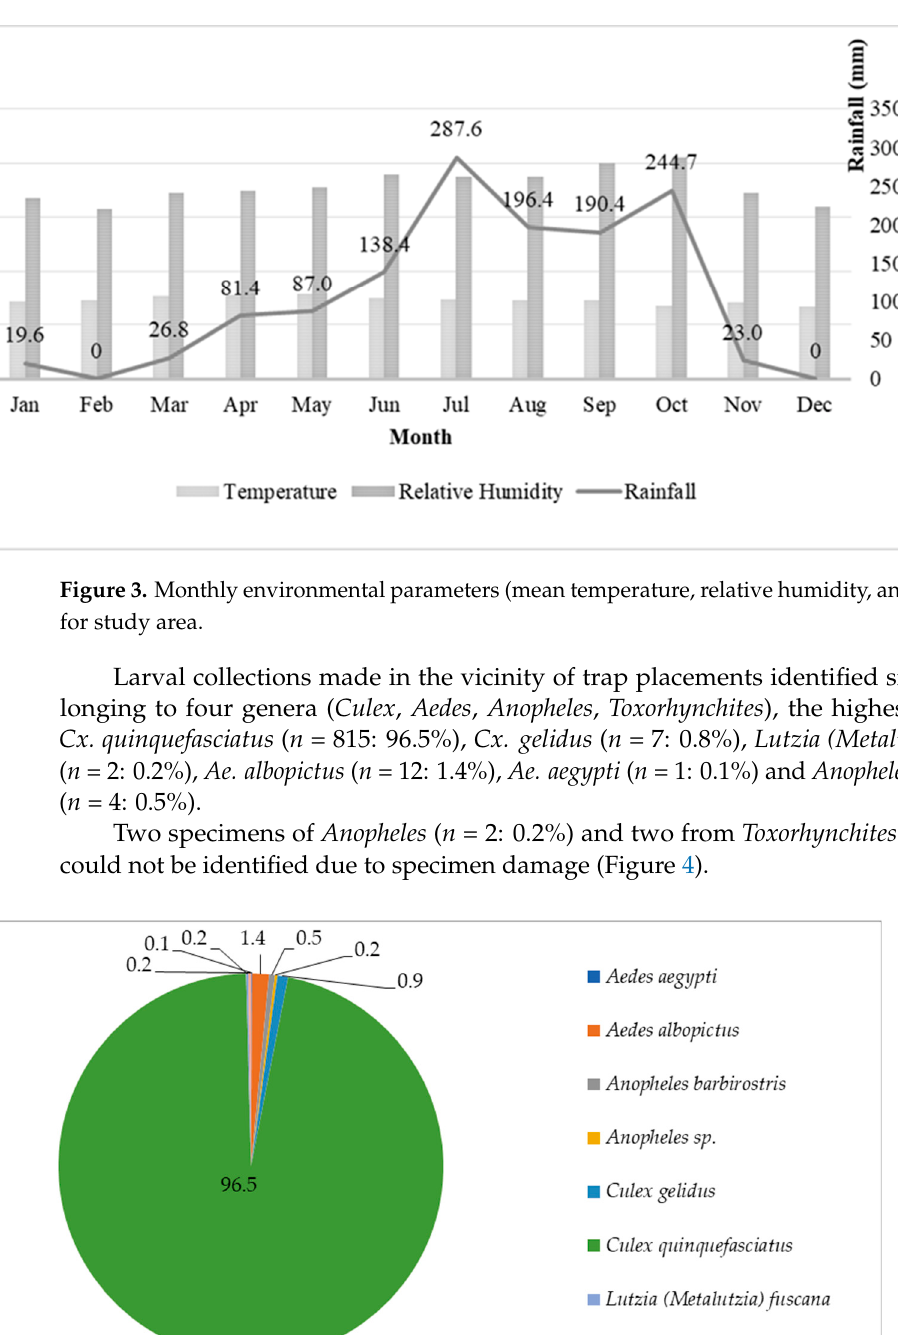
Figure 4. Proportion of mosquito species obtained from larval collections of nearby trap locations.